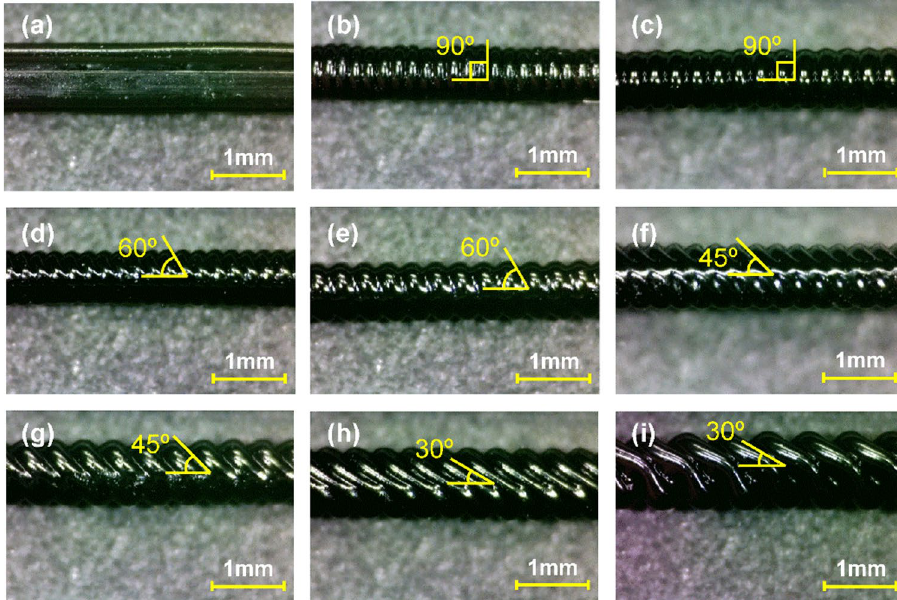
Figure 3. Optical images of the PLA mixing channel molds with various printing (raster) angles and resolutions: ( a ) 0°–200 μm, ( b ) 90°–200 μm, ( c ) 90°–300 μm, ( d ) 60°–200 μm, ( e ) 60°–300 μm, ( f ) 45°–200